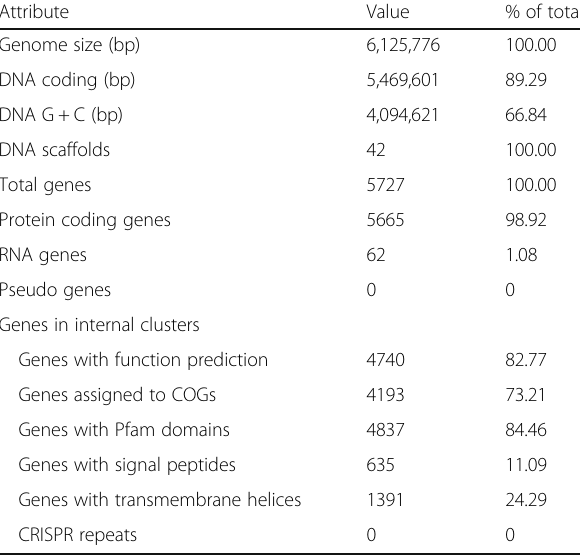
Table 3 Genome statistics